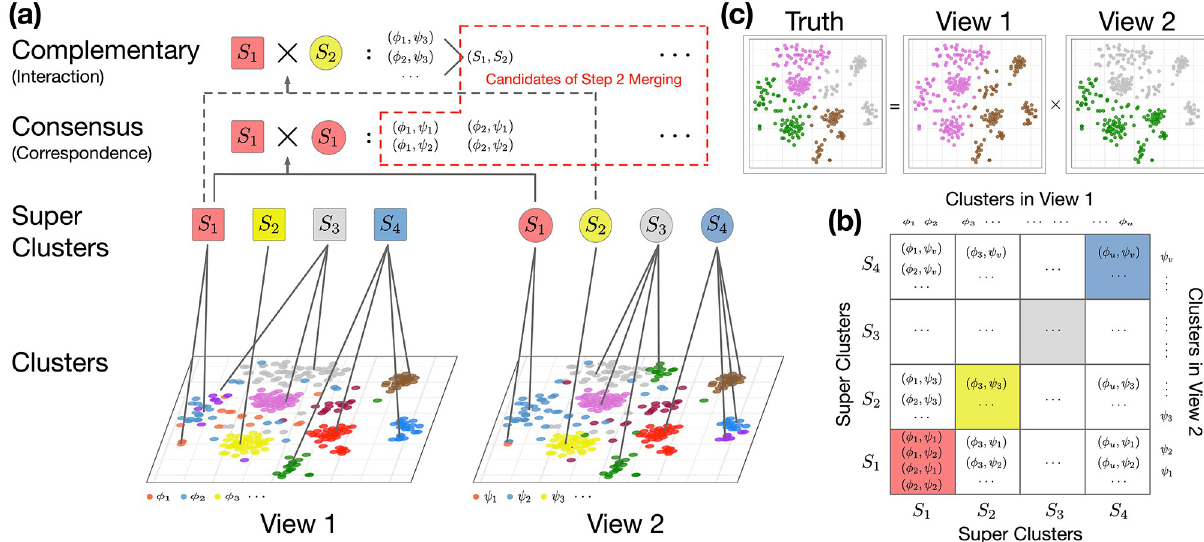
Fig 2. First-stage merging of Cartesian product clusters based on bipartite clustering. (a) Bipartite clustering yields super-clusters, each containing multiple clusters in every view. A super-cluster is marked by a given color, and the same super color is shown by different shapes in the two views. Any super-cluster of interaction effects will be treated as a merged product cluster in later analysis. (b) The off-diagonal white blocks correspond to unmatched product (UP) super-clusters. The diagonal colored blocks correspond to matched product (MP) super-clusters. (c) A simple case that the true clusters are the product clusters from two views. The information from the two views is fully